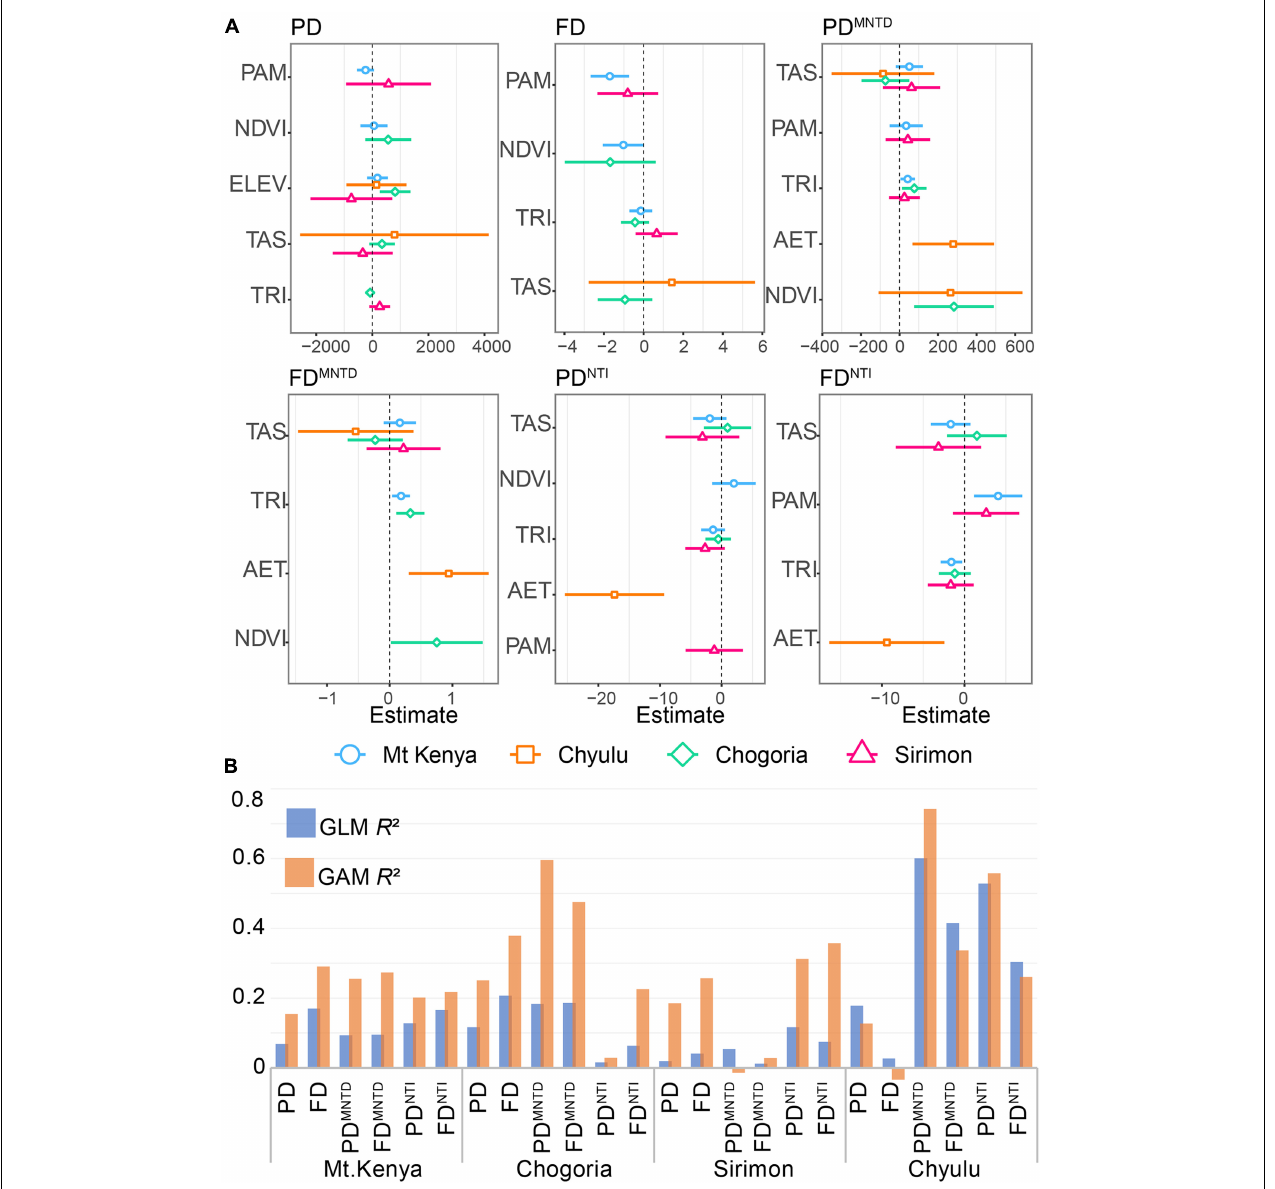
FIGURE 4 | The regression coefficients of association between diversity variances and environmental predictors. (A) Plots of regression coefficients summarizing the association between predictors and indices between the sites. (B) The proportion of diversity variances accounted for by the combination of predictors retained in the best-fit